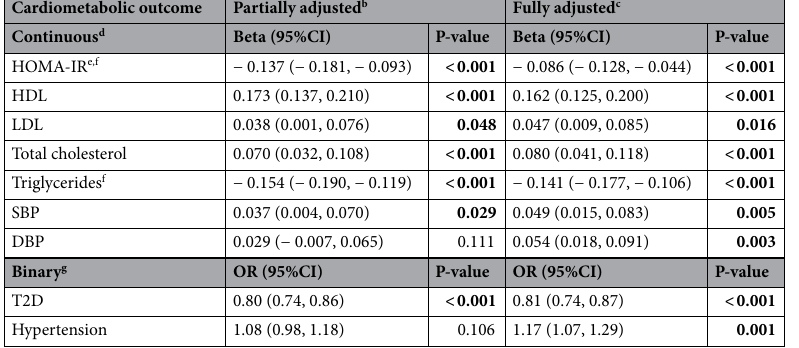
Table 2. Associations between adiponectin and cardiometabolic outcomes a . a Values are presented per 1 SD increase in log transformed adiponectin. b The partially adjusted model is adjusted for age, sex, and population stratification. SBP and DBP are additionally adjusted for blood pressure medication use. c The fully adjusted model is adjusted for age, sex, population stratification, BMI, alcohol consumption, and smoking. SBP and DBP are additionally adjusted for blood pressure medication use. d Values are betas with corresponding 95% Confidence Intervals. e ‡ T2D cases were excluded for all HOMA-IR analyses. f HOMA-IR and Triglycerides were log transformed. g Values are odds ratios with corresponding 95% Confidence Intervals.